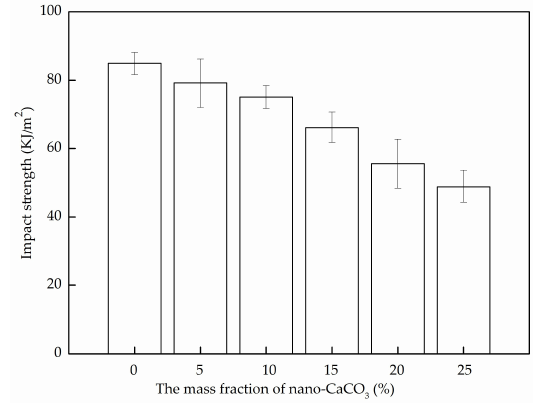
Figure 4. Impact strength of core–shell structured WPCs.